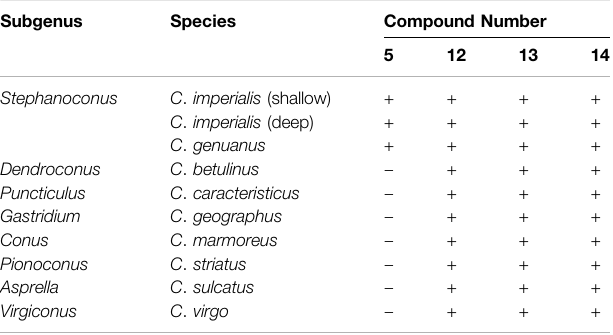
TABLE 1 | The most abundant purine derivatives observed in Conus venom glands (plus (cid:1) present; minus (cid:1) absent) a . Subgenus